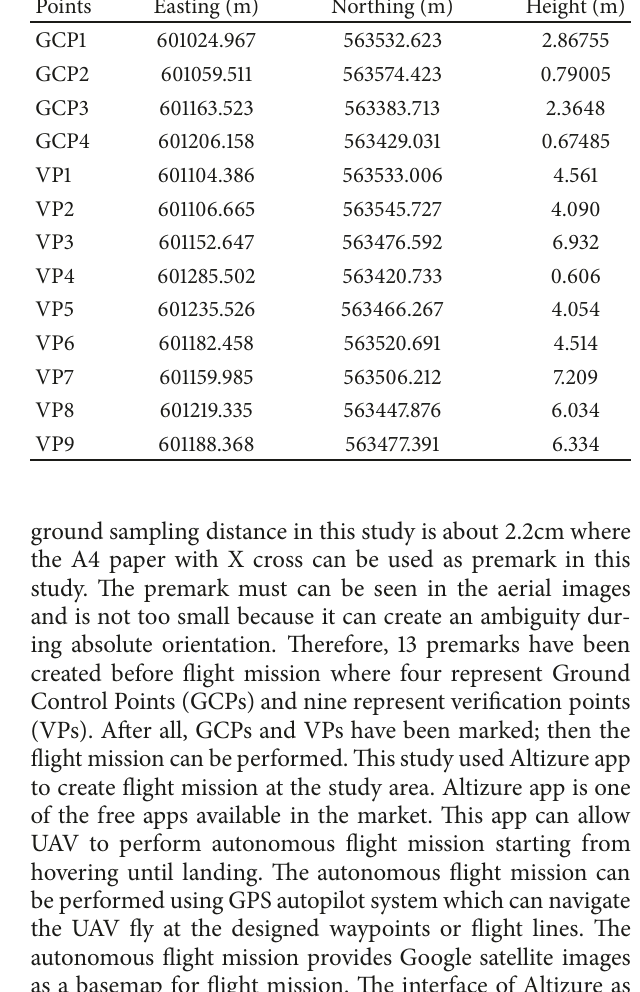
Table 1: The aircraft and sensor specification (dji.com 2016).